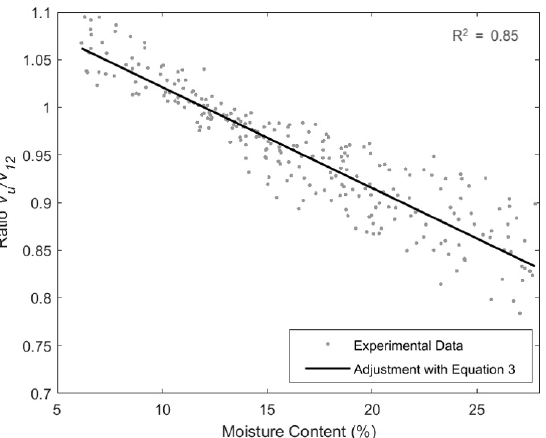
Figure 3. Correlation between MC and relative ultrasound (5%–28%) trend line for Cypress.